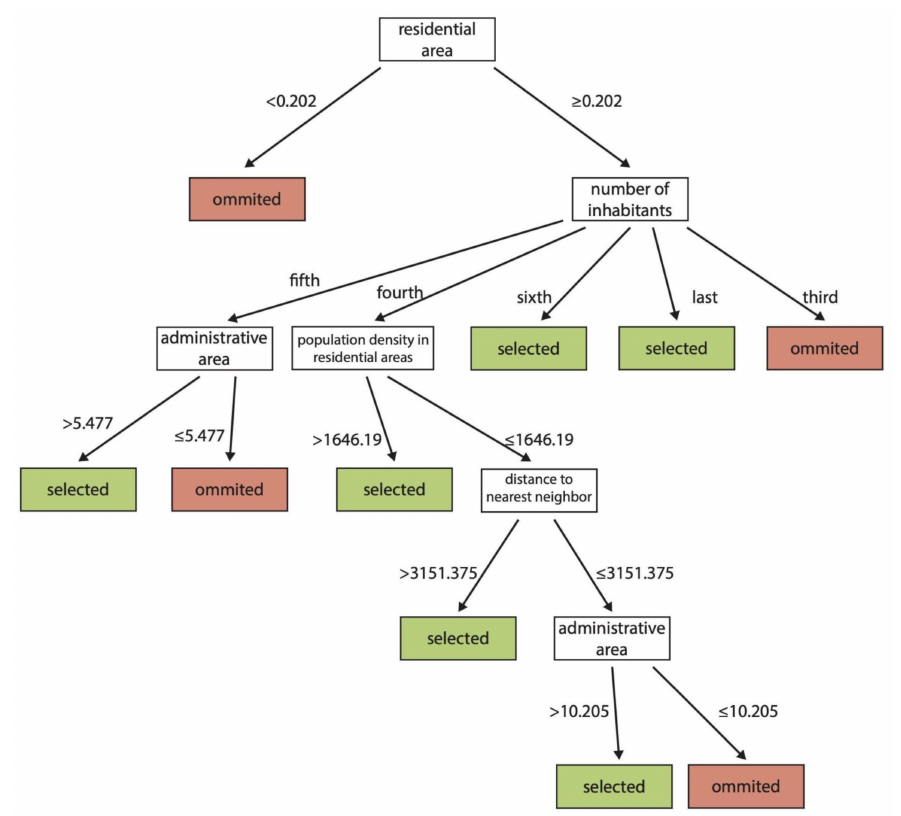
Figure 6. Decision tree for group 2, result of machine learning using the DT-GA